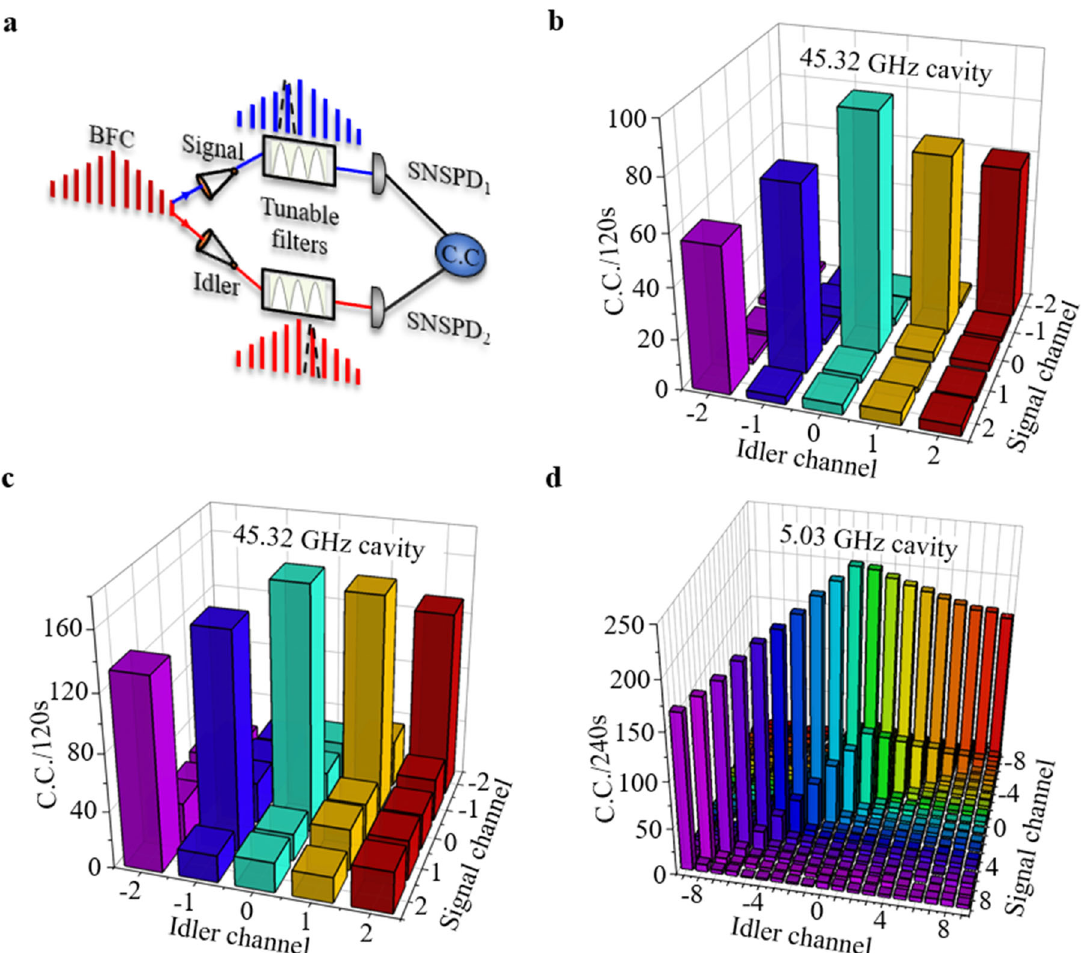
Fig. 2 Quantum frequency correlations of high-dimensional BFCs. a Experimental schematic for the joint spectral intensity measurement for the high-dimensional quantum state. Signal and idler photons are sent to two tunable narrowband fi lters for the frequency-bin correlation measurement with coincidence counting. b Measured frequency correlations of the 45.32 GHz BFC using fi lters that had matched FWHM bandwidths of 300 pm and were manually tuned for scans from the − 2 to + 2 frequency bins from frequency degeneracy. The SPDC source was pumped at ≈ 2 mW for these measurements, which produced relatively high coincidence counts only along the diagonal elements of the correlation matrix. The cross-talk between frequency bins was less than 11.71 dB. c Measured frequency correlations of the 45.32 GHz BFC when the SPDC crystal was pumped at ≈ 4 mW, showing increased signal-idler frequency-bin cross-talk to 6.31 dB. d Higher-dimensional frequency-bin joint spectral intensity measurements for the 5.03 GHz BFC. The fi lters used here had matched FWHM bandwidths of 100 pm and were temperature tuned for scans from the − 9 to + 9 frequency bins from frequency degeneracy. The off-diagonal components increase compared to those in Fig. 2a because the effective bandwidth of the tunable narrowband fi lters spanned multiple FSRs in this